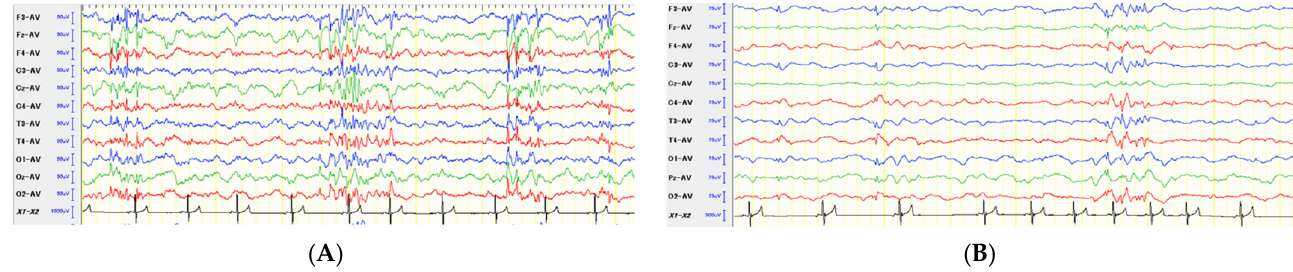
Figure 1. Scalp EEGs before ( A ) and at 12 months after ( B ) the 2nd surgery (anterior 2/3 CC) in Case 1. Generalized and synchronized multiple spike complex with high amplitude was observed frequently preoperatively ( A ). Postoperatively, some spikes were synchronized bilaterally, but spike spread, frequency, and amplitude were improved remarkably ( B ).